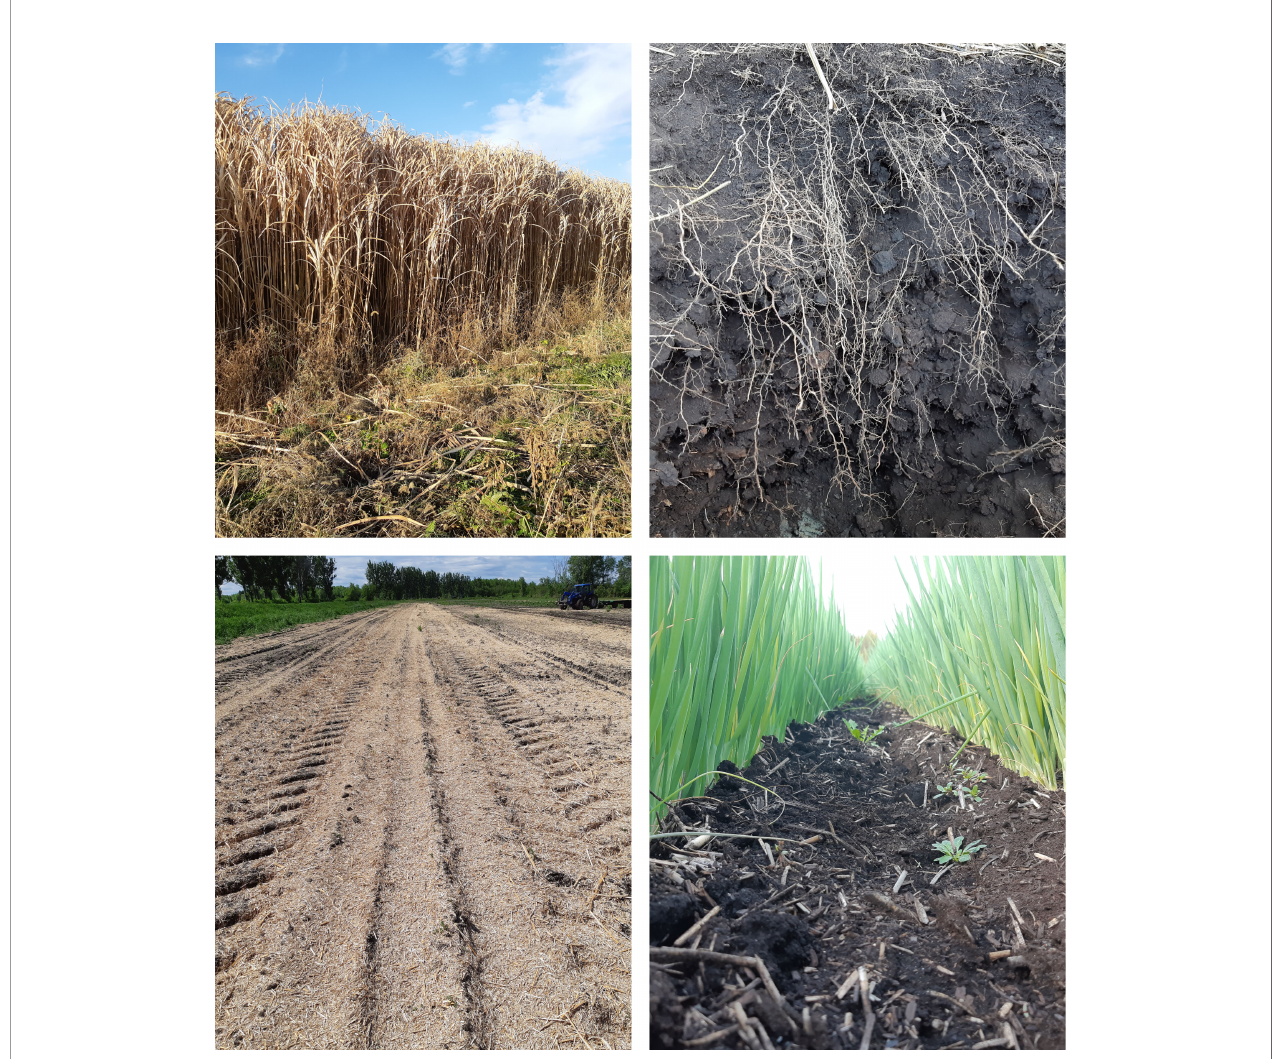
FIGURE 5 | Miscanthus production on degraded organic soils. Upper left: Miscanthus fi eld; upper right: miscanthus root pro fi le; bottom left: fi eld application of chopped miscanthus; bottom right: growth of green onion on miscanthus amended organic soil: Photo credit: Jacynthe Dessureault-Rompre ́